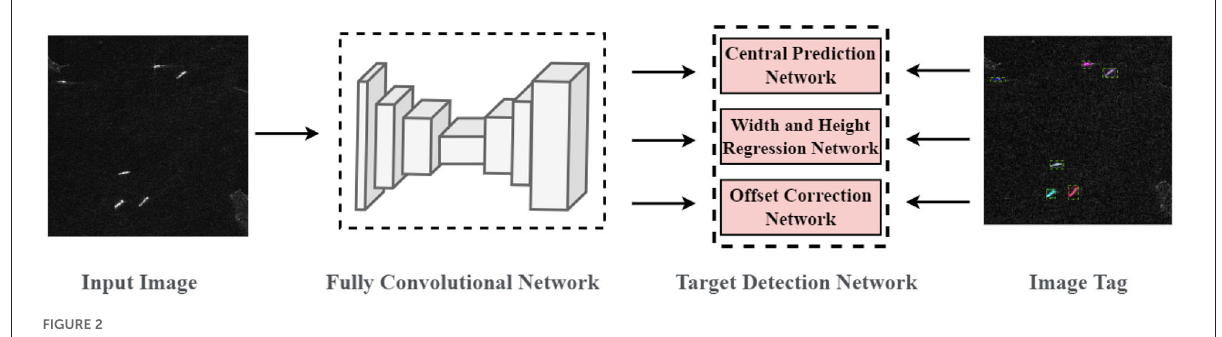
FIGURE2 Structure diagram of the proposed